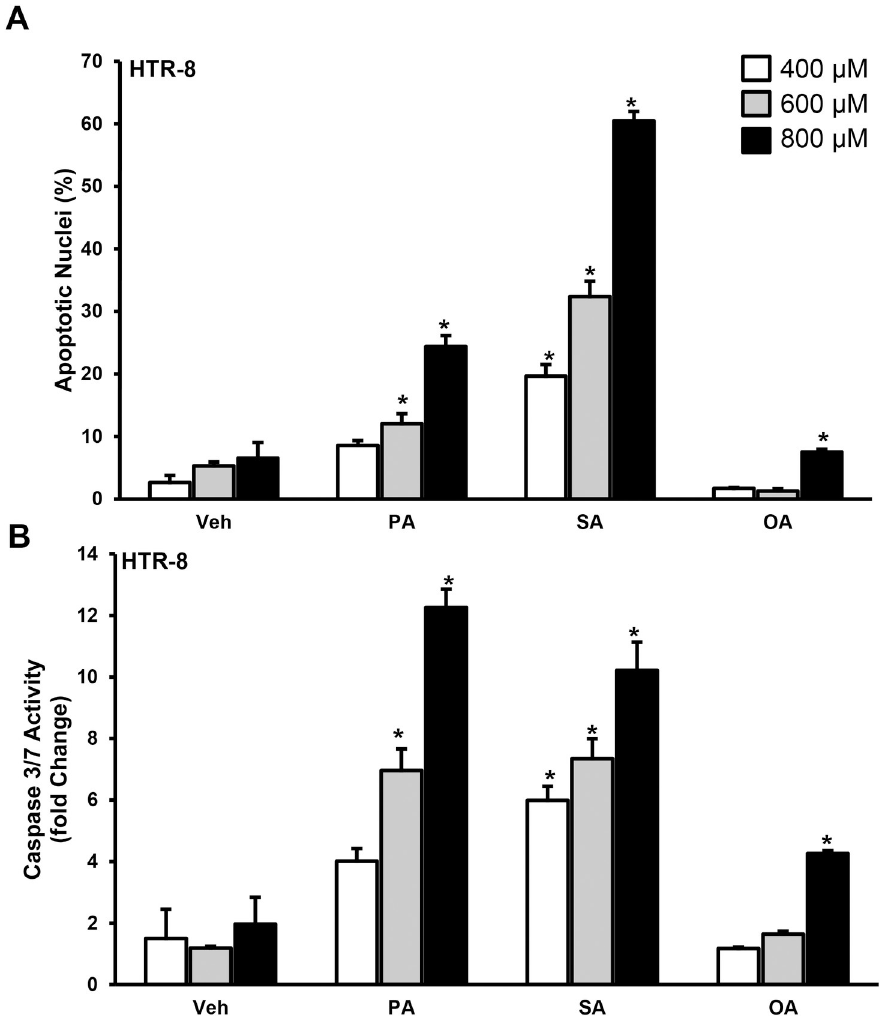
Fig 2. FFAs induce trophoblast lipoapoptosis in human normal immortalized first trimester-derived trophoblast cells, HTR-8SV/neo (HTR-8). HTR-8 cells were treated with palmitate (PA), stearate (SA), oleate (OA) or vehicle (Veh) for 24 hr. Percent apoptotic nuclei (A) and caspase 3/7 activity (B) were significantly elevated in PA- and SA- treated trophoblasts, but not in vehicle and OA-treated trophoblasts. These data represent the mean ± sem, n = 4 and � P < 0.05 compared to